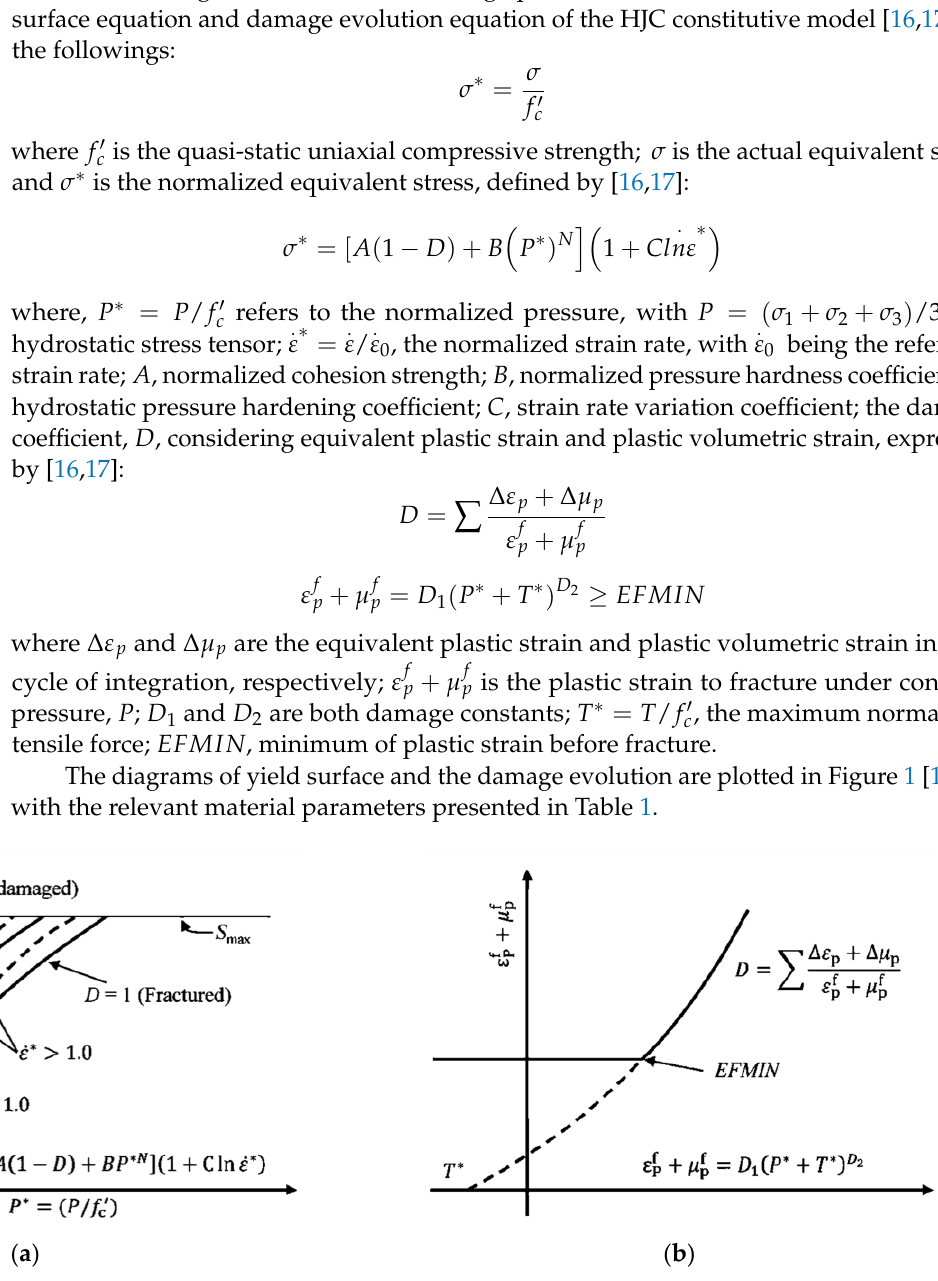
Figure 1. Description of HJC constitutive model: ( a ) representation of yield surfaces; ( b ) visualization of damage evolution function